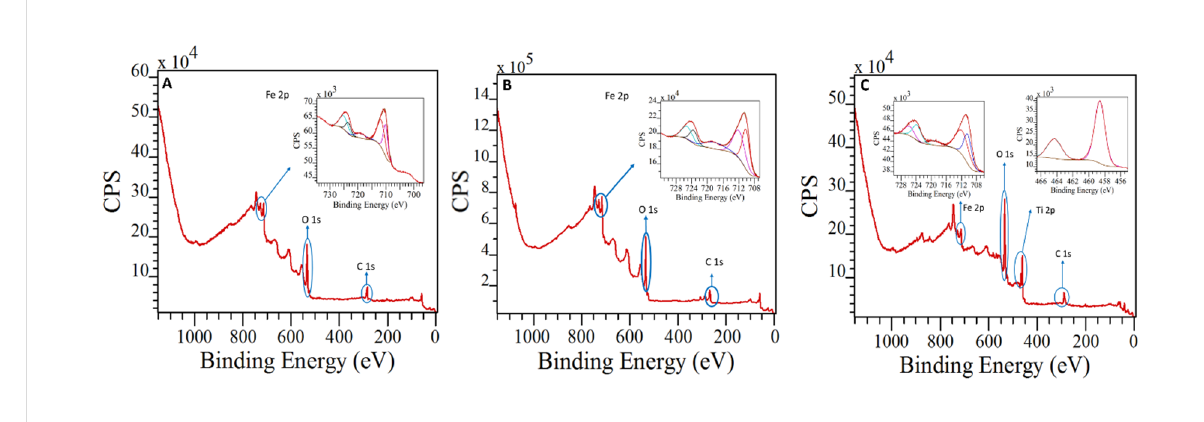
Figure 2: XPS spectra of A: Fe 2 O 3 -PS4, B: Fe 2 O 3 -PS4-MNP and C: TiO 2 -Fe 2 O 3 -PS4 nanohybrids.